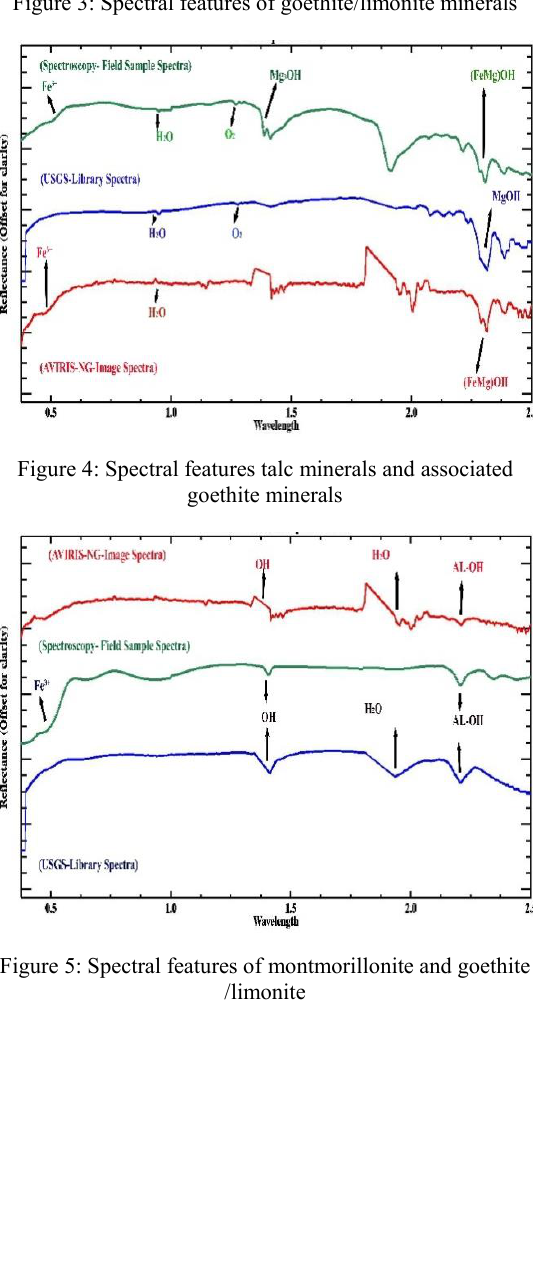
Figure 3: Spectral features of goethite/limonite minerals